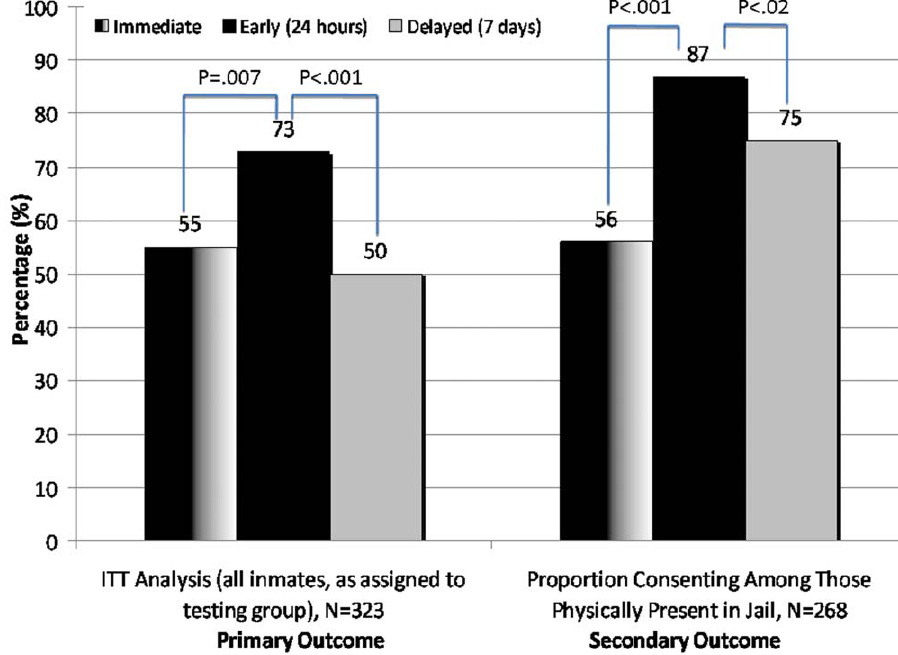
Figure 2. Rapid HIV Testing Swab Results by Assigned Testing Group.